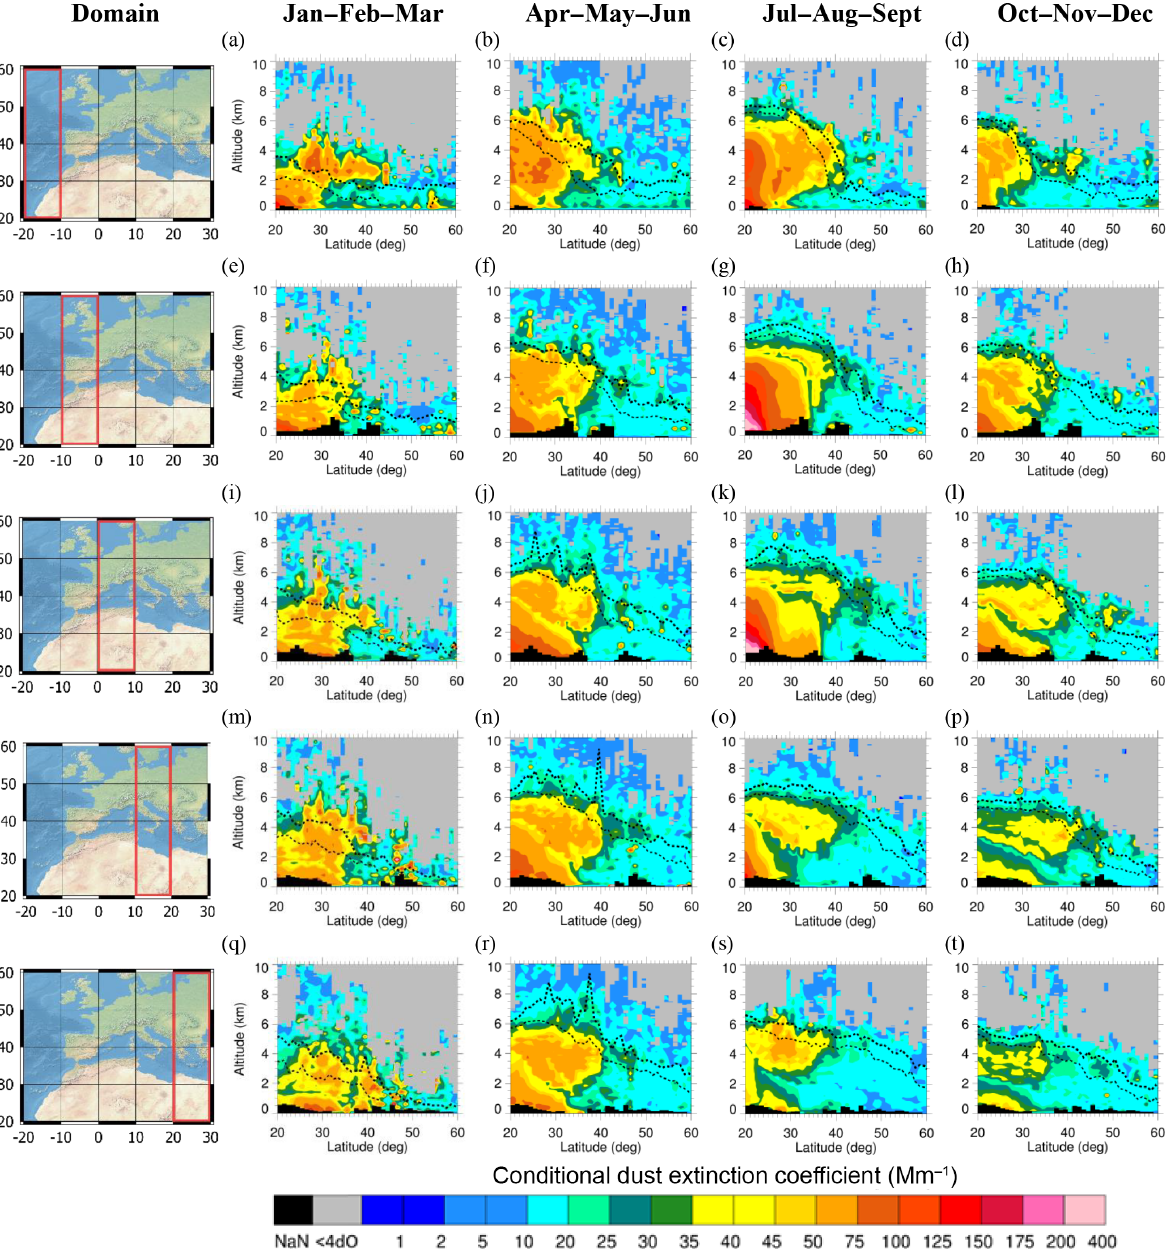
Figure 6. Geographical zonal distribution of the conditional dust extinction coefficient values (Mm − 1 ) measured by CALIPSO dust product for the regions 10 to 20 ◦ W (a–d) , 0 to 10 ◦ W (e–h) , 0 to 10 ◦ E (i–l) , 10 to 20 ◦ E (m–p) and 20 to 30 ◦ E (q–t) for the latitudinal regions from 10 ◦ N to 60 ◦ N as illustrated by domain maps for the 3-month averages: January–March (a, e, i, m, q) , April–June (b, f, j, n, r) , July–September (c, g, k, o, s) and October–November (d, h, l, p, t) . The median terrain elevation is depicted with black